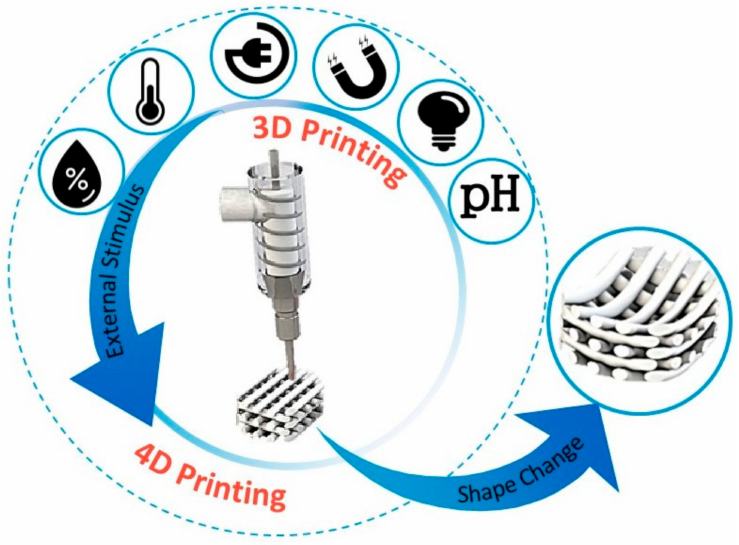
Figure 2. Illustrative diagram representing addition of a predesigned stimulus to promote a desired change at the construct. [Original image from the